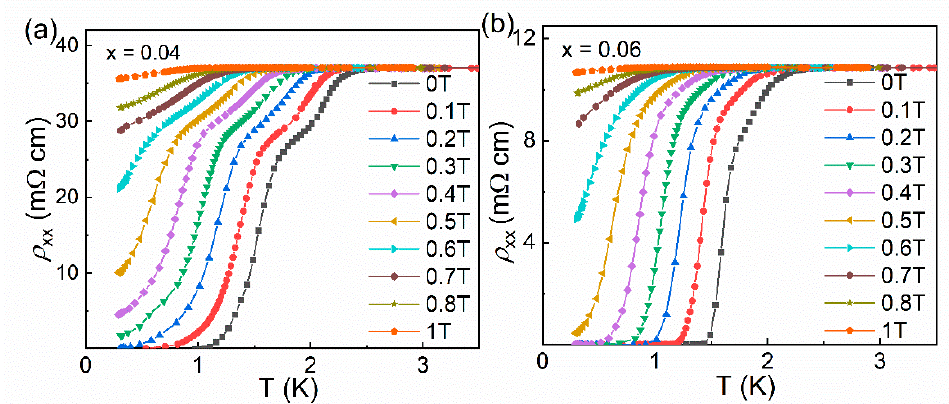
Figure 3. Temperature dependence of longitudinal resistivity, ρ xx ( T ) , measured under various magnetic fields for In 0.04 Sn 0.96 Te ( a ) and In 0.06 Sn 0.94 Te ( b ) single crystals.